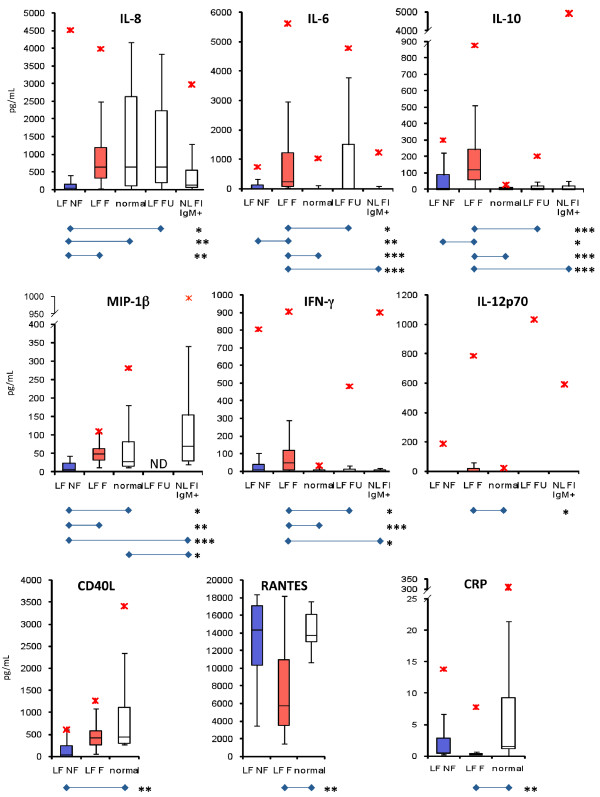
Levels of relevant cytokines in LF pathogenesis. Serum levels of IL-8, Il-6, IL-10, and MIP-1β showed significant differences between LF NF and LF F patients on admission. For LF NF patients, IL-8 levels were significantly reduced when compared to LF F, normal, and LF FU subjects. Elevated levels of IL-6 and IL-10 were recorded in LF F patients, but were significantly lower in LF NF subjects. MIP-1β was significant reduced in LF NF only when compared to LF F patients. Interferon-γ was significantly higher for fatal LF patients than normal donors and follow-up controls, but IFN-γ levels did not differ between fatal and nonfatal LF patients. Similarly, IL12p70 levels were significantly elevated in LF F when compared to normal donors, but did not differ from the other comparison groups. CD40L was significantly reduced in LF NF when compared with normal controls, but not in LF F. Cytokine levels were relatively similar between LF NF and NL FI IgM+ groups, with the exception of MIP-1β, which was elevated in the later cohort. Outliers are denoted with red asterisks (*). Significant p values for pairwise comparisons are denoted as * p < 0.05; ** p < 0.01; and *** p < 0.001.